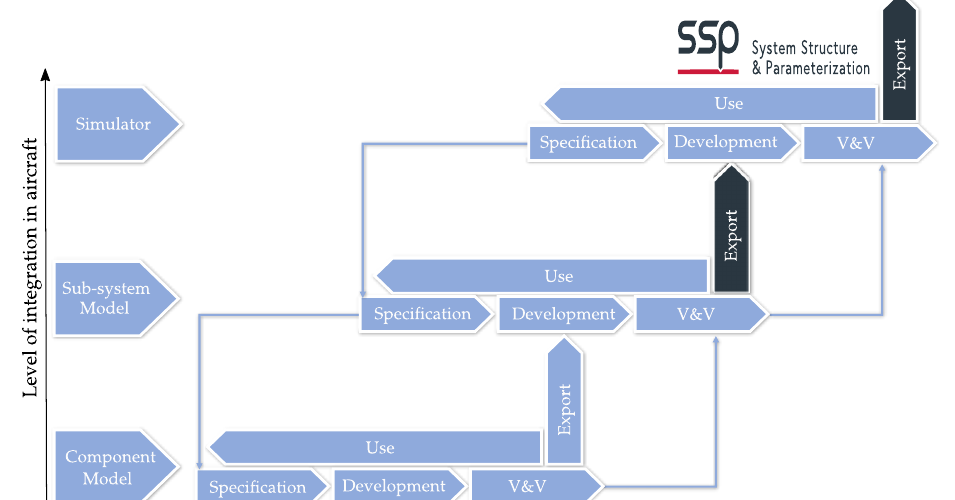
Figure 1. Simulation application development process connecting the Component Model, Sub-system Model, and Simulator levels of abstraction. The term Model here refers to mathematical simulation models as specified by Ljung [9] and Fritzon [10]. A simulator here is also seen as a mathematical simulation model composed of several connected models or simulators exported from a lower level of hierarchy [13]. The V&V activities are seen as bottom up, a view that is in line with the Validation Level per Level approach [6]. The natural connection between the two standards, FMI and SSP, and the activities of the simulation application development process are highlighted in the figure.